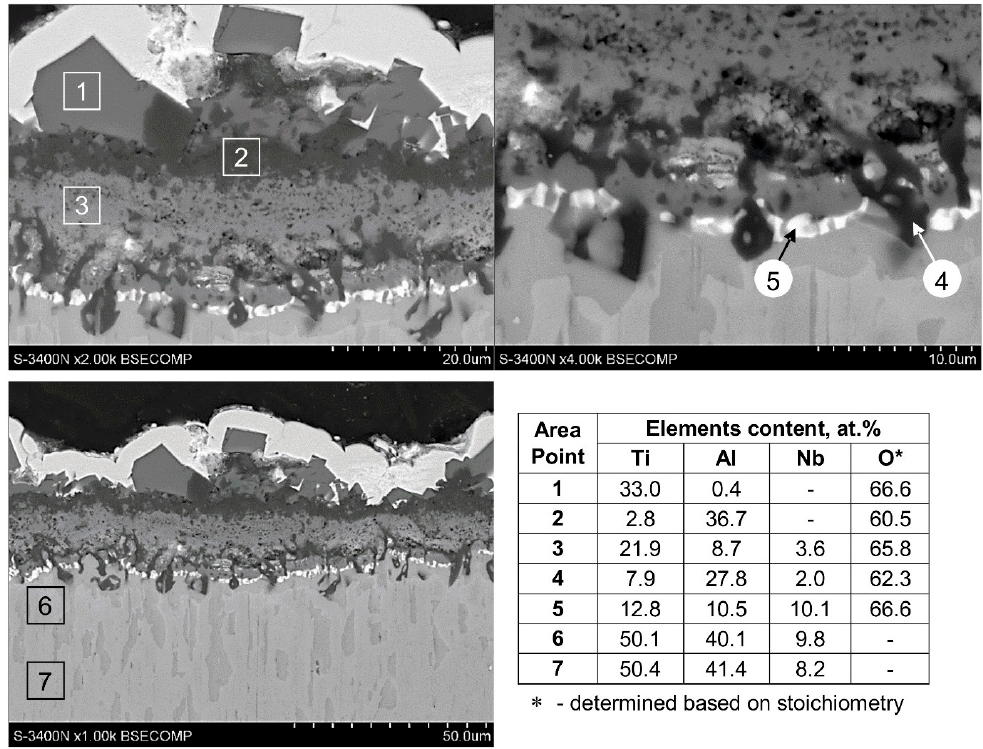
Figure 13. The microstructure (SEM) and EDS results of the oxide scale formed on aluminized Ti–45Al–8Nb–0.5(B, C) alloy during 100 cycles of isothermal oxidation at 950 °C.